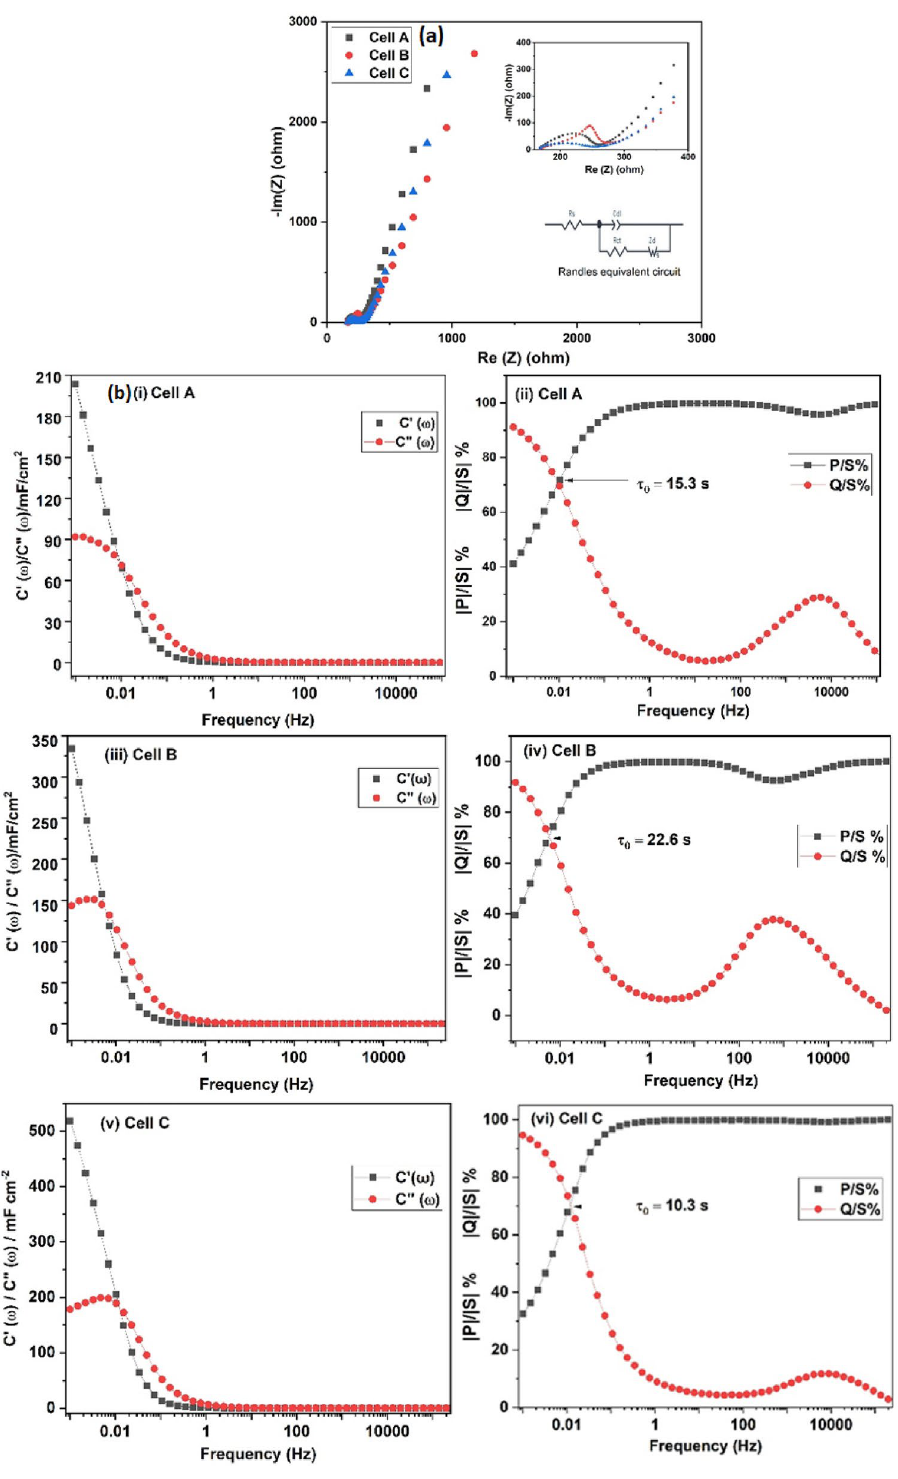
Figure 6. ( a ) EIS plot of Cell #A–#C at 1 mHz recorded at room temperature, ( b ): ( i ): Bode plots for the real and imaginary part of complex capacitance as a function of frequency (in logarithmic scale), ( ii ): normalized active power |P|/|S| and reactive power |Q|/|S| as a function of frequency (in logarithmic scale) for Cell #A, ( iii ): Bode plots for the real and imaginary part of complex capacitance as a function of frequency (in logarithmic scale), ( iv ): normalized active power |P|/|S| and reactive power |Q|/|S| as a function of frequency (in logarithmic scale) for Cell #B, ( v ): Bode plots for the real and imaginary part of complex capacitance as a function of frequency (in logarithmic scale), ( vi ): normalized active power |P|/|S| and reactive power |Q|/|S| as a function of frequency (in logarithmic scale) for Cell